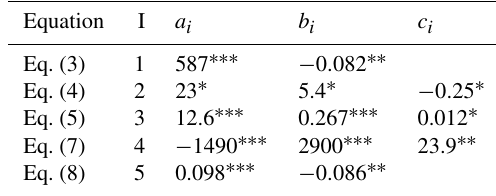
Table 4. Coefficients ( a – c ), corresponding indices i , and signifi- cance levels for the equations presented in Sect. 3.2. The equation coefficients were fitted using FB chamber measurements and yield fluxes in units of µgN 2 O-Nm − 2 h − 1 . The input quantities are the soil temperature T S (in units of degrees Celsius), time since end of grazing (cid:49)t EOG (in units of days), and volumetric water content VWC (as a dimensionless fraction).